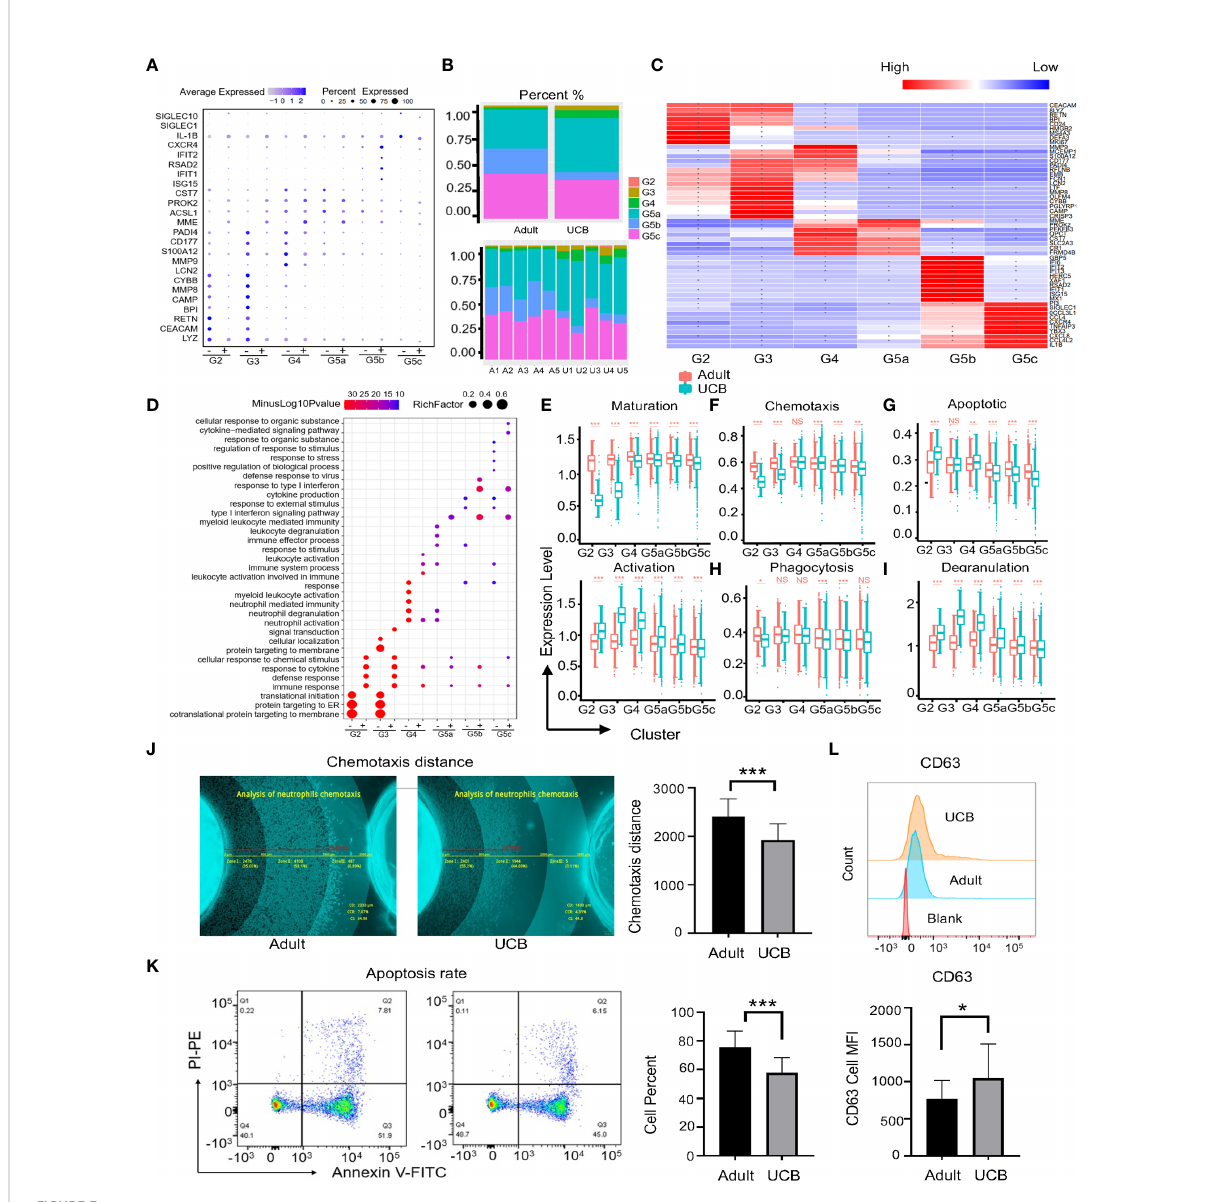
FIGURE 3 Functional differences among neutrophil subgroups between UCB and healthy adult. (A) Neutrophils conserved marker genes. ‘ - ’ means neutrophils in UCB, and ‘ + ’ represents healthy adult neutrophils. (B) Plots of subpopulations in different groups and samples. (C) Heatmap of differentially expressed genes in subsets of neutrophils between healthy adult and UCB. Asters represent gene expression differences between UCB and healthy adults. (D) Scale diagram of GO-BP analysis of various subsets of neutrophils in healthy adults and UCB. ‘ - ’ means DEGs up- regulated of adults, while ‘ + ’ represents DEGs up-regulated of UCB neutrophils. (E – I) Functional scores of neutrophil subgroups. Neutrophil maturation and activation (E) ; Neutrophil chemotaxis (F) and apoptosis (G) ; Neutrophil phagocytosis (G) and degranulation. (J – L) Neutrophil functional evaluation in vitro . Chemotaxis of neutrophils in healthy adults and UCB (J) . Neutrophil apoptosis in healthy adults and UCB (K) . The expression levels of CD63 in neutrophils of healthy adult and UCB (L) . Data represent means±s.d. (n=3 – 5) of two independent experiments. *p < 0.05, **p < 0.01, ***p < 0.001, ns, not